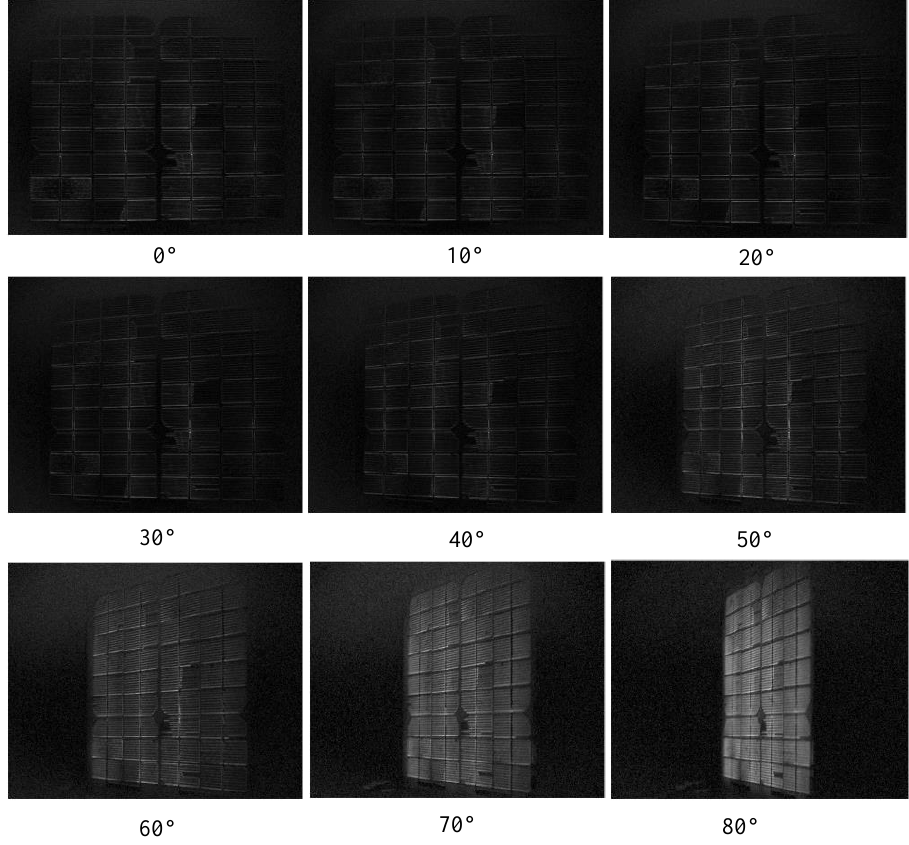
Figure 16. Images DOP of monocrystalline silicon photovoltaic panel with view angle.